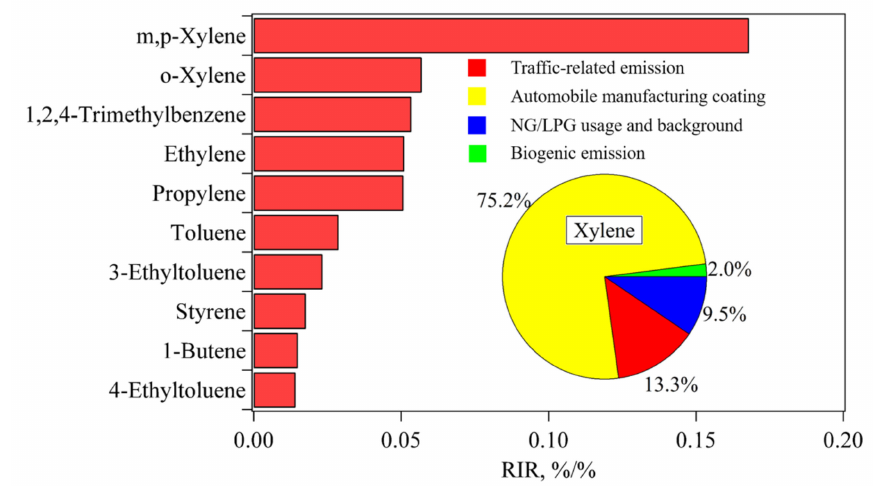
Figure 13. Anthropogenic NMHC species with top ten RIR values during the pollution